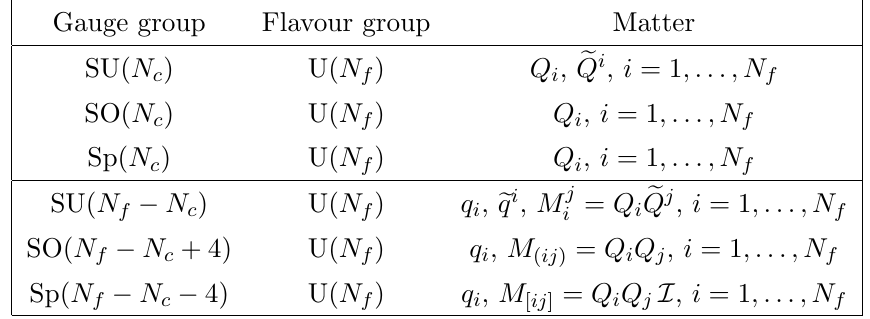
(cid:0) N + 3) and instan- c f